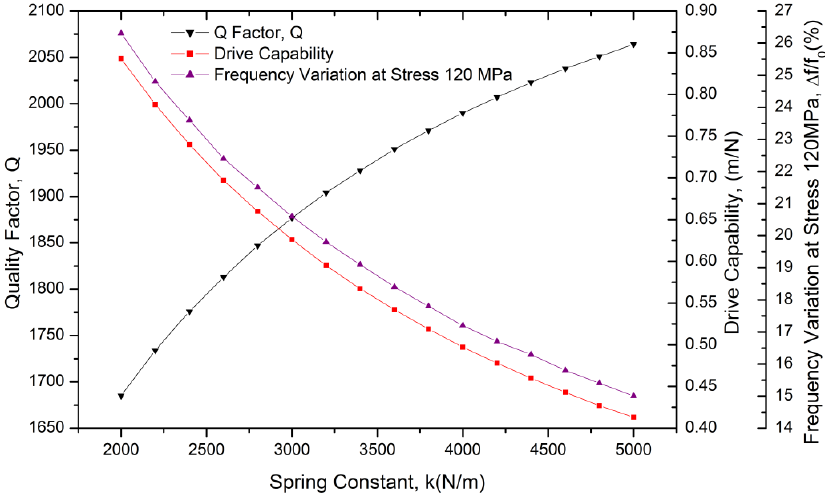
Figure 4. The relationships between the Q-factor, frequency variation at full scale stress of 120 MPa, drive capability and spring constant of the resonator.